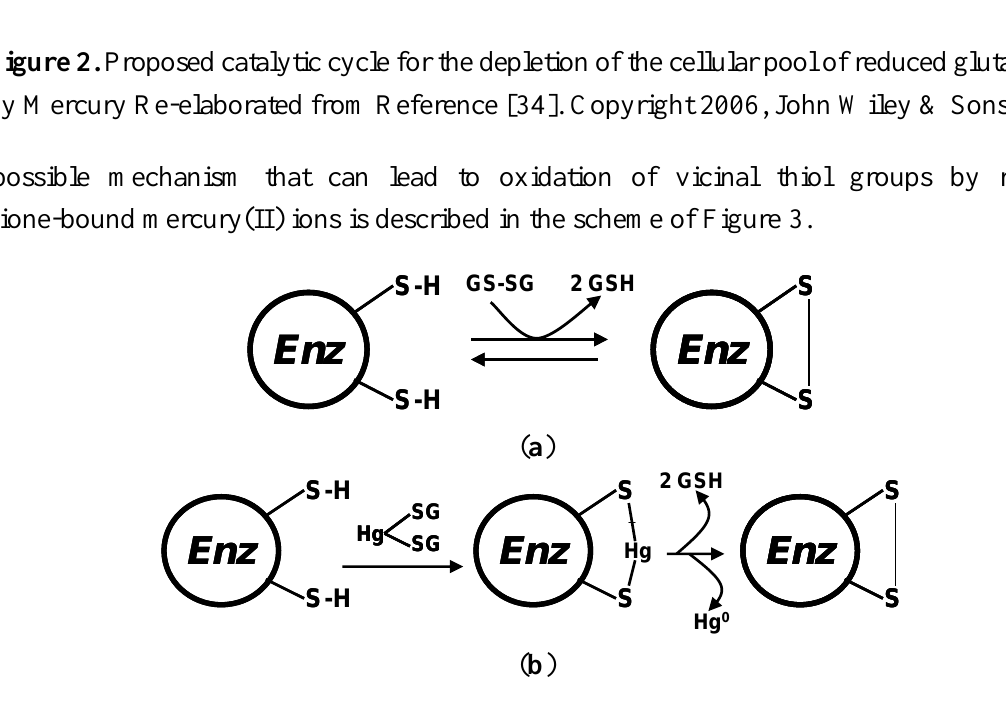
Figure 3. Possible mechanisms for the inhibition or inactivation of enzymes by glutathione-bound mercury. ( a ) is the physiological mechanism for enzyme action or regulation by the glutathione/glutathione disulfide redox pair; ( b ) is the interaction of glutathione-bound mercury with the vicinal thiol groups with intermediate transfer of mercury to the vicinal thiol pair, followed by oxidation of the thiols to an intramolecular disulfide and reduction of mercury(II) to the elemental